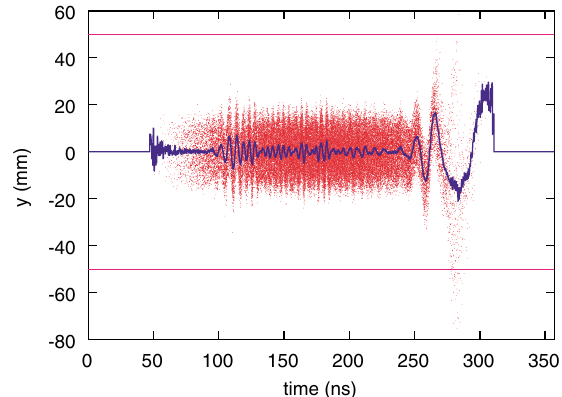
FIG. 21. (Color) Macroparticles and smoothed offset for the last turn of the PSR simulation using parameters in Table II. The vertical aperture is shown too.